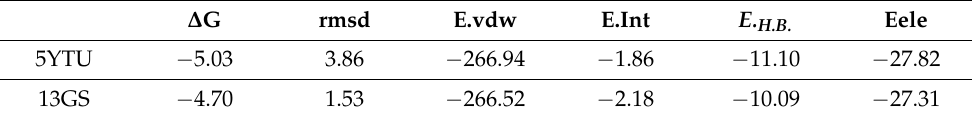
Table 5. The docking energy scores (kcal/mol) for Na 2 SeO 3